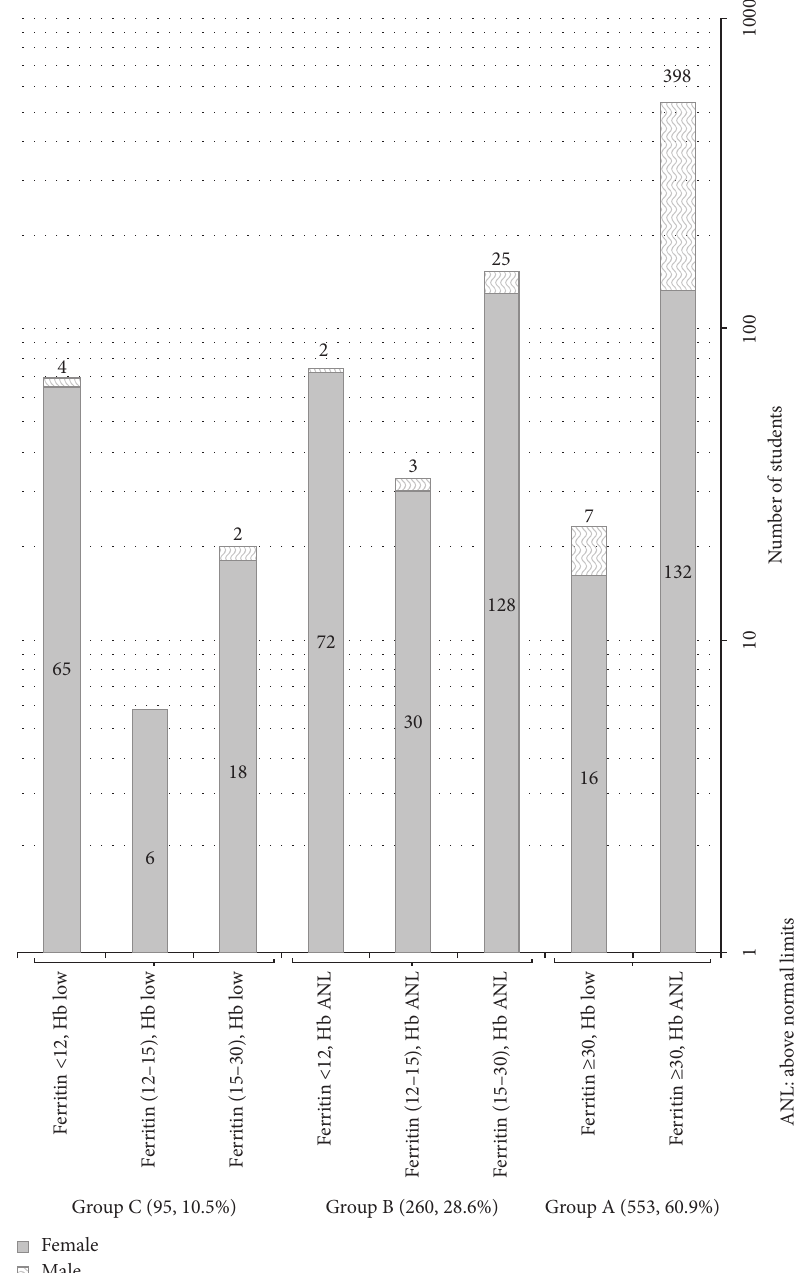
Figure 1: Sufficiency profile with respect to ferritin and Hb by